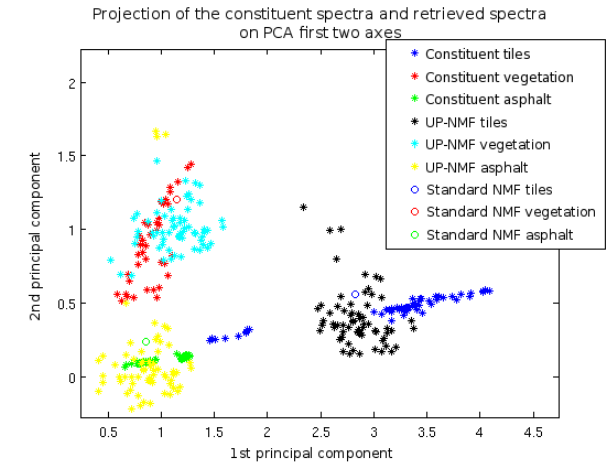
Figure 6. Projection onto the first two PCA axes of constituent spectra (blue, red, green stars), UP-NMF spectra (black, cyan, yellow stars) and standard NMF spectra (blue, red, green circles).